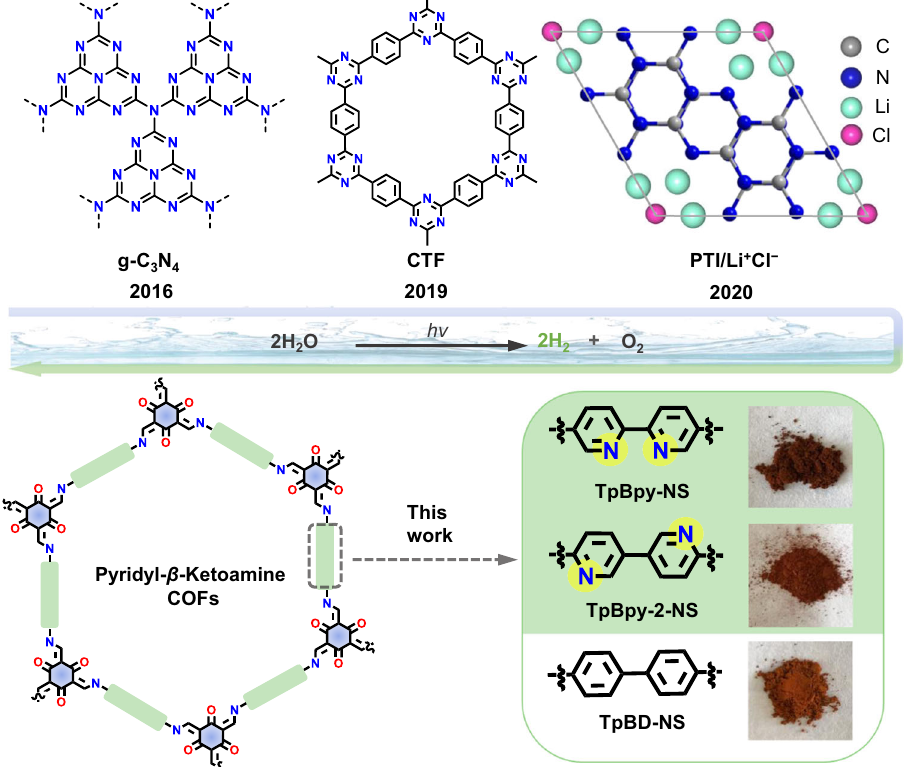
Fig. 1 | The brief development of organic photocatalysts for overall water splitting and related photocatalysts in this work. g-C 3 N 4 graphitic carbon nitride, CTFs Covalent Triazine Frameworks, PTI Polytriazine Imide, COFs Covalent Organic Frameworks,